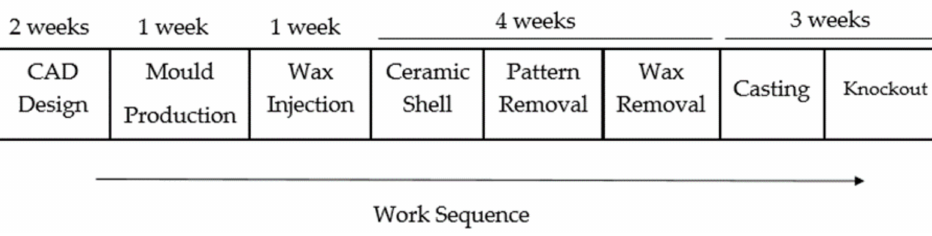
Figure 8. Timeline of the key steps of this